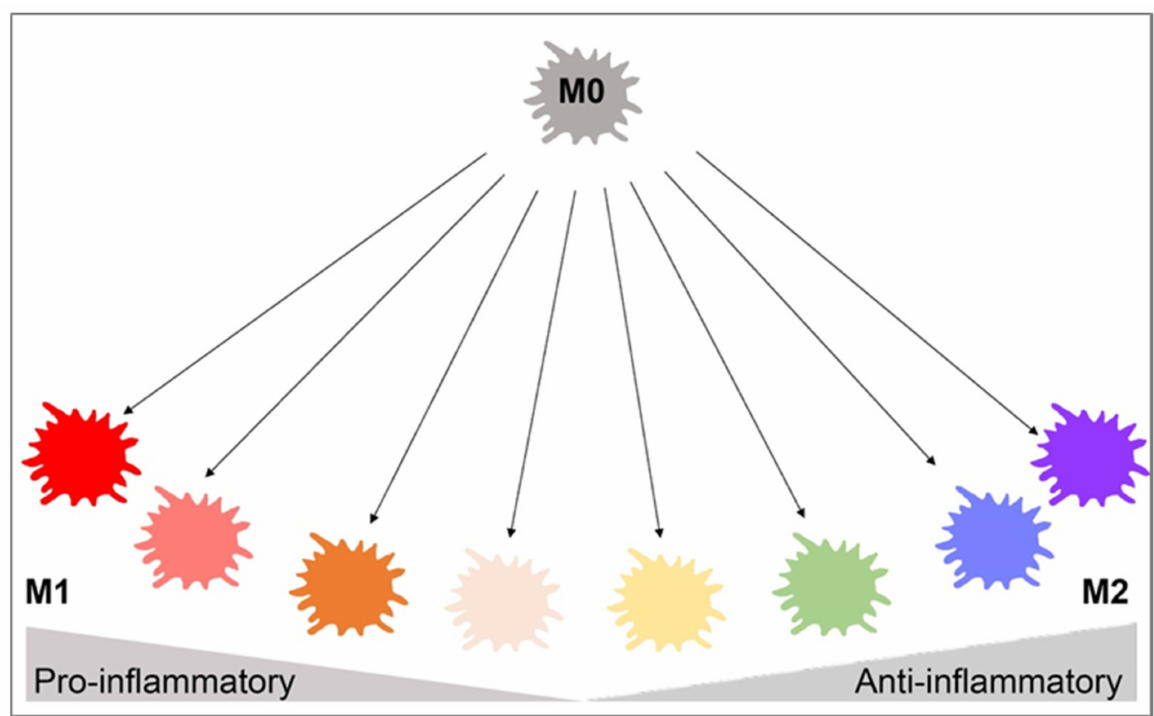
Figure 1. Macrophage polarization gradient. This figure illustrates the heterogeneity of macrophage polarization in place of binary M1/M2 classifications. The pro-inflammatory M1 and anti-inflammatory M2 cells lie on opposite ends of the polarization axis, but many macrophages with mixed pro- and anti-inflammatory characteristics exist in between. Environmental changes may cause macrophages to shift from M1 to M2, vice versa, or to a hybrid of both cells. This highlights the plasticity of macrophages and interdependence on the surrounding environment. This figure was created with Biorender.com (accessed on 1 May 2021).